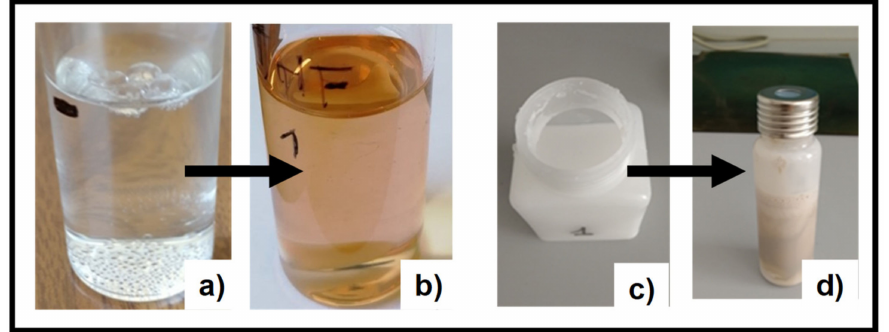
Figure 2. Photographic image of M.L.1 (TPU-AgNP-1) and M.L.5 (WPU-AgNP) before ( a , c ) and after ( b , d ) sun light exposition. M.L.: mother